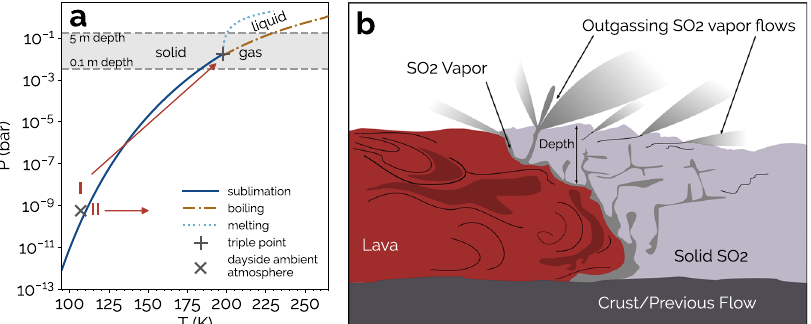
Fig. 2 Above ambient sublimation vapor pressures on Io. a The SO 2 phase diagram, with the phase transitions depicted as lines. The triple point and representative dayside ambient conditions are marked. The shaded box denotes basal pressures that could be exerted by solid SO 2 capping the lava-SO 2 interaction region. The arrows depict alternate thermodynamic pathways following the lava-frost interaction. b The geometry of the considered lava-SO 2 frost interaction. The light grey regions all consist of SO 2 vapor, which outgas as vapor fl ows upon reaching the surface.